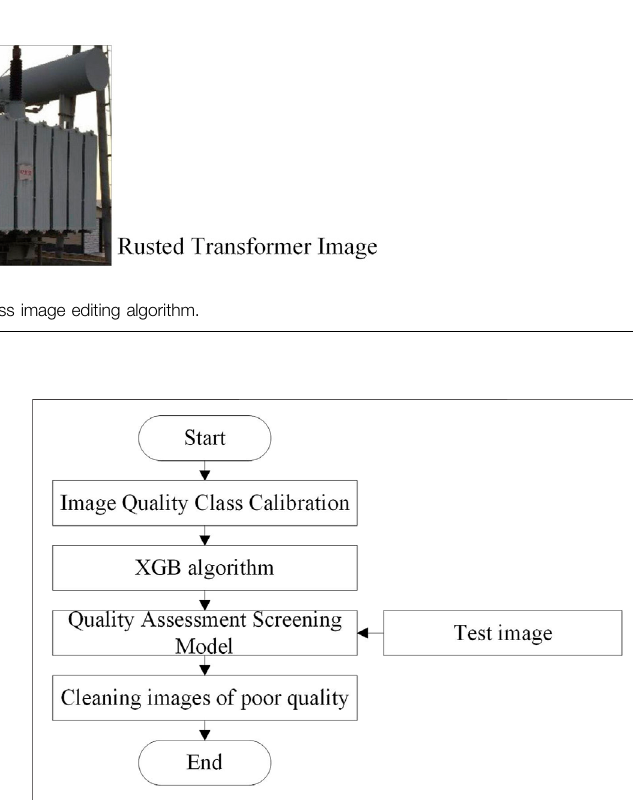
FIGURE 4 | Image quality assessment and cleaning